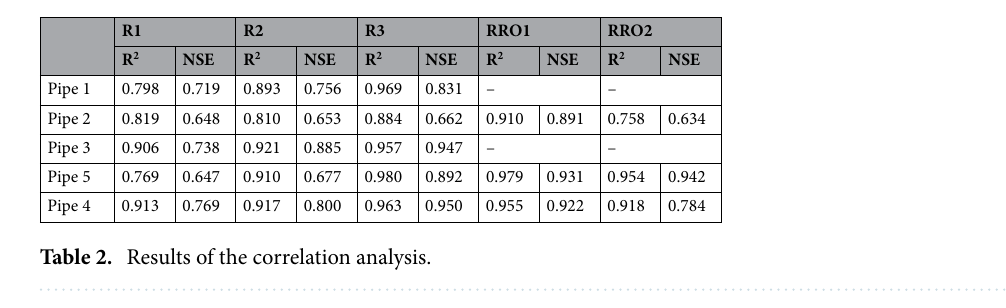
Figure 6. Modeled and measured water depths. ( a ) Pipe 4 values. ( b ) Values for point S1.